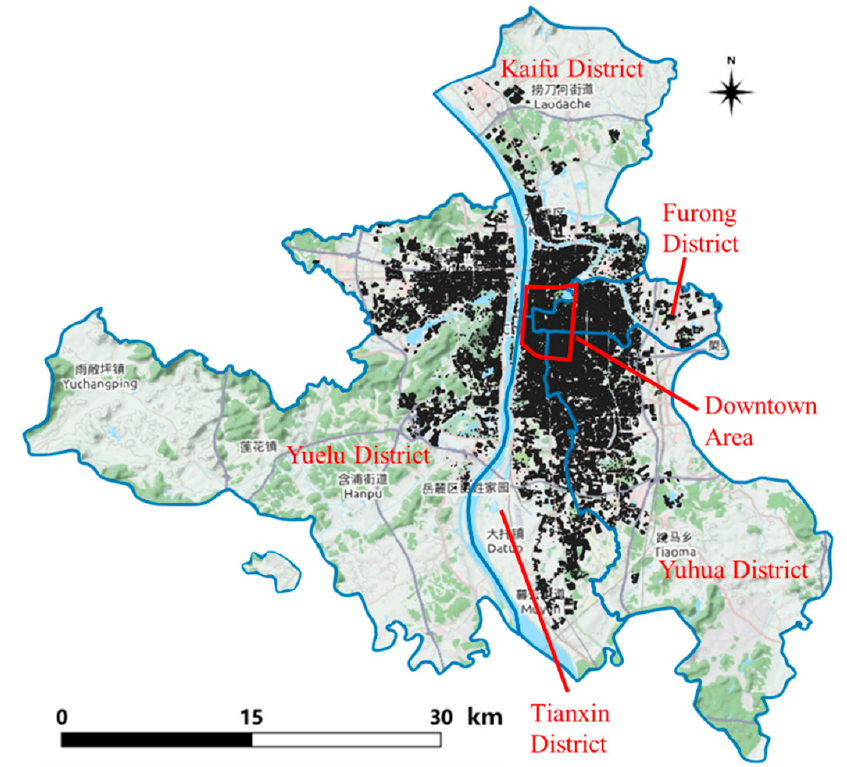
Figure 2. Case study area: five districts in Changsha.